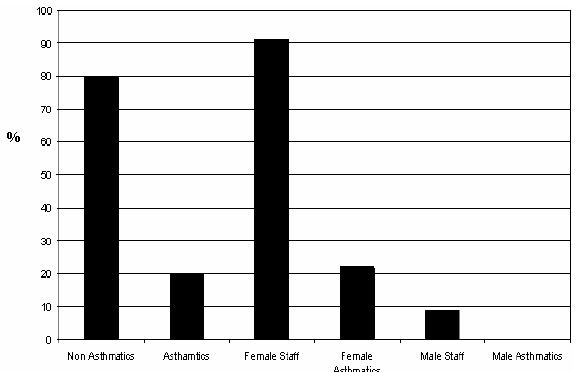
Figure 5: Profile of school’s administrative personnel (including teachers) with asthma per gender.